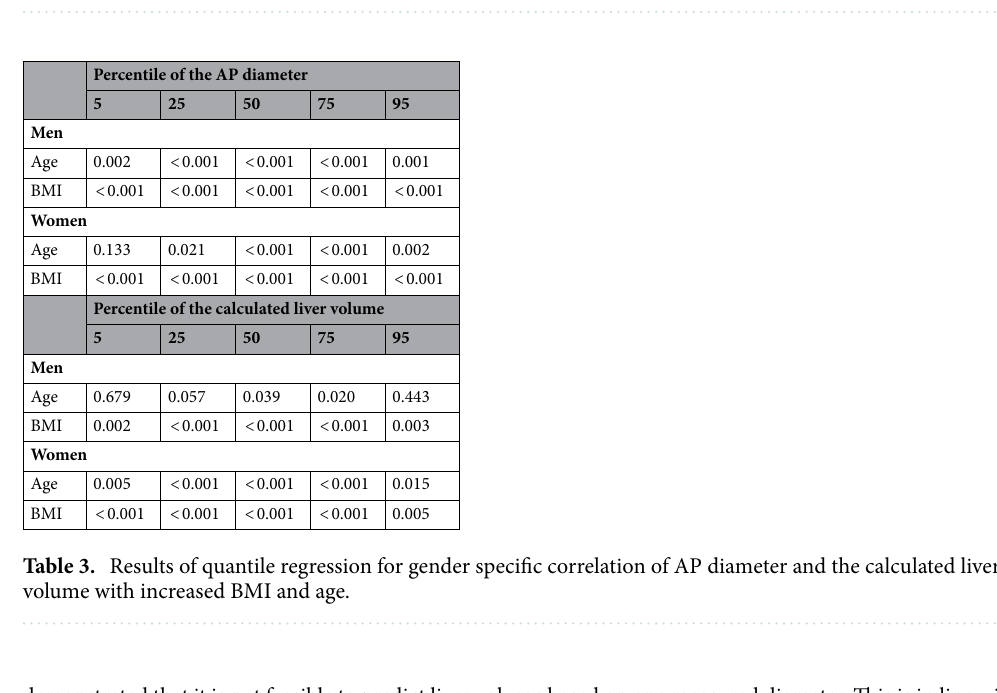
Figure 2. Overview of maximum AP diameter in patients with and without liver parenchymal changes.